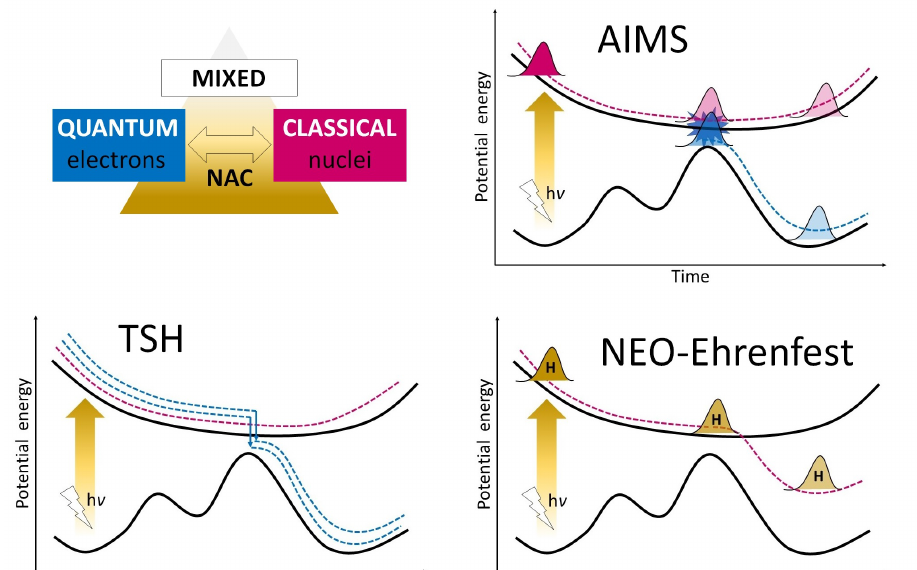
Figure 3. Schematic illustration of the mechanisms of the discussed NA-MQC dynamic approaches: trajectory surface hopping (TSH), ab inito multiple spawning (AIMS), and nuclear–electronic orbital Ehrenfest